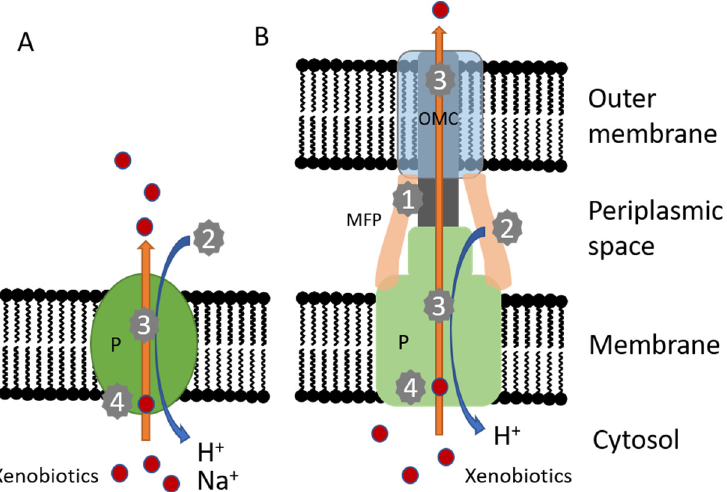
Figure 1. Scheme of secondary active multidrug efflux pumps with selected possible targets of inhibitors. ( A ) Single component pump (e.g., MFS pump), ( B ) Tripartite RND pump. Both types are driven by an electrochemical potential. Inhibitors might (1) interfere with the assembly of the tripartite pump, (2) inhibit the electrochemical gradient, (3) block the efflux pump channel or outer membrane protein exit channel or (4) interfere either with the binding site of efflux pump substrates or inhibit the essential conformational changes during the efflux process. P pump, MFP membrane fusion protein, OMC outer membrane channel.